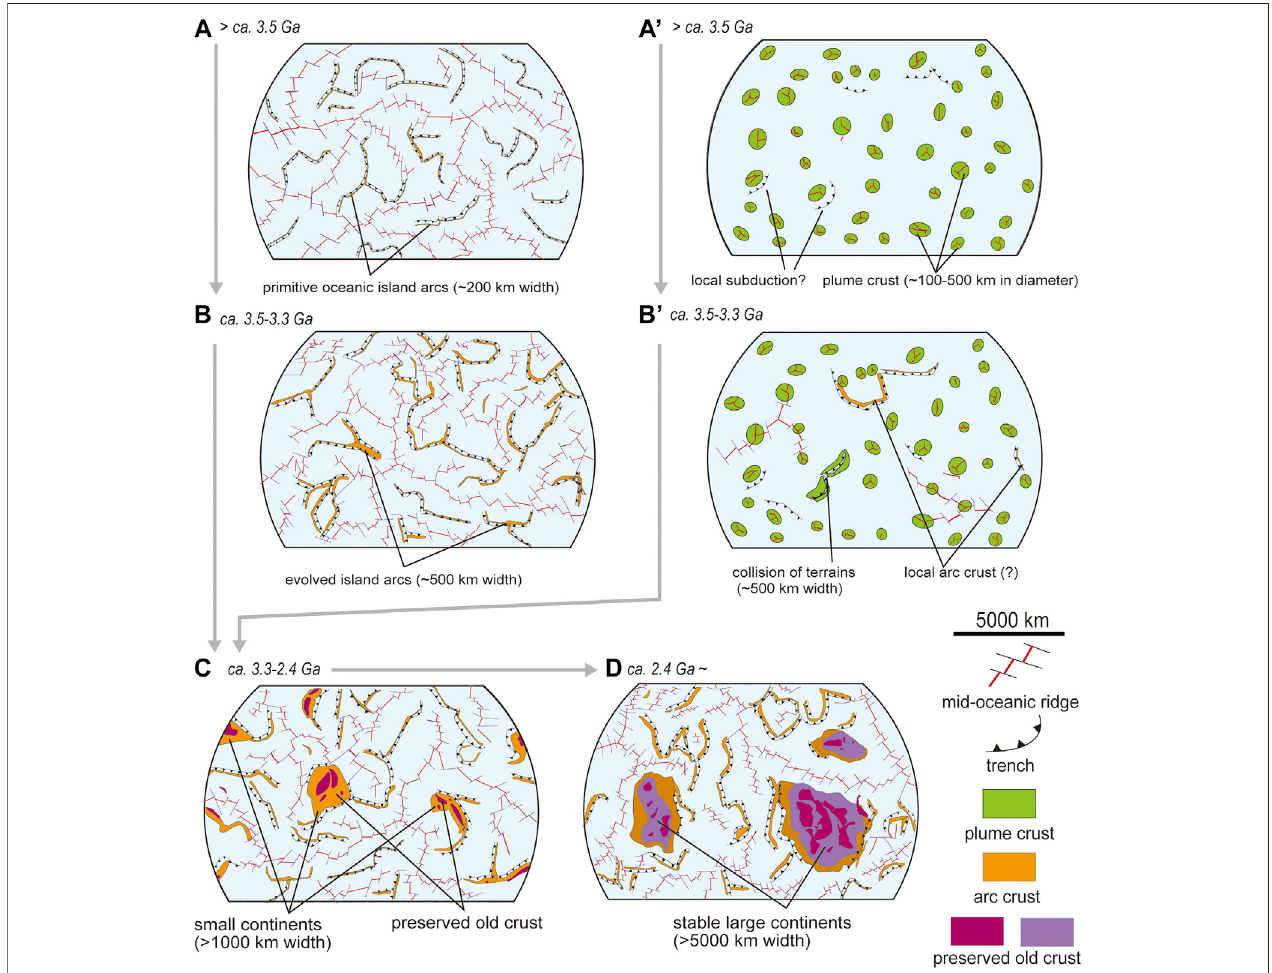
FIGURE 5 | Map view of secular change in the size of continents modi fi ed after Sawada et al. (2018). (A) After the start of the plate subduction, many narrow and thin oceanic islandarc-likecontinental crust wereproduced. (B) Through theamalgamationofthe narrow,thin continentalcrust, evolved continental blockswithawidth ofover500 km.OldHadeanandearlyArcheancrustshadbeenpreservedintheinteriorofthecontinentalblocks. (A 9 ) Platesubductionwasstilllimitedandthethinfelsic crust was conceived in plume-related ma fi c crust. (B 9 ) After the start of plate subduction, the plume crust gradually amalgamated and larger continental blocks emerged.Productionofarccrustlikelystarted. (C) Largercontinentswithovera1,000 kmwidthappearedaround3.3 Ga.Mostofthecontinentsduringthisperiodwere not as large as the modern ones, although some exceptions with nearly a 5,000 km width likely existed during 3.2 – 3.0 Ga. (D) The Archean continents fi nally amalgamated to form large continents similar to modern